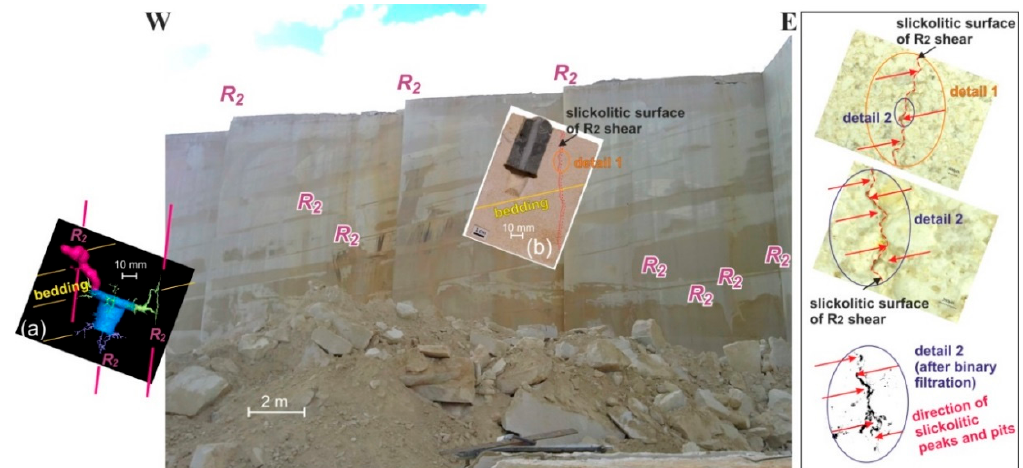
Figure 13. Correlation of results obtained with help of the CT 3D model in ( a ) the W–E direction and ( b )